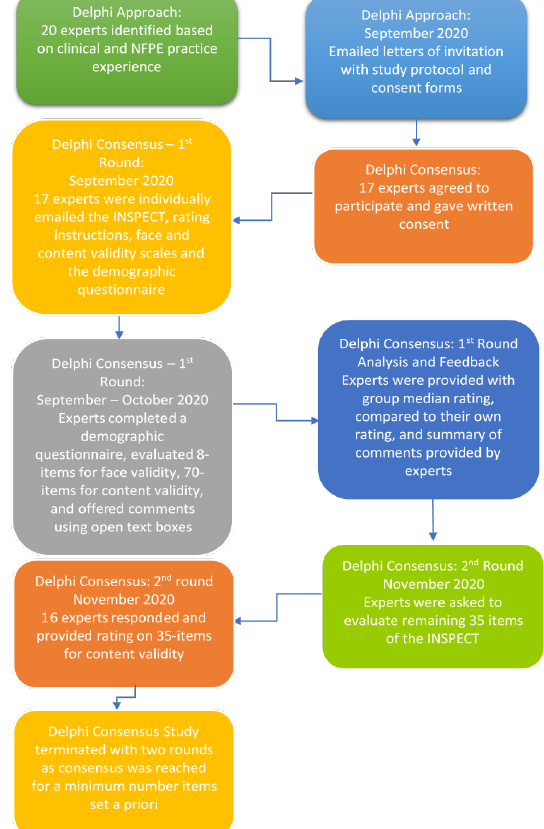
Figure 1. The flow chart of Delphi consensus for the